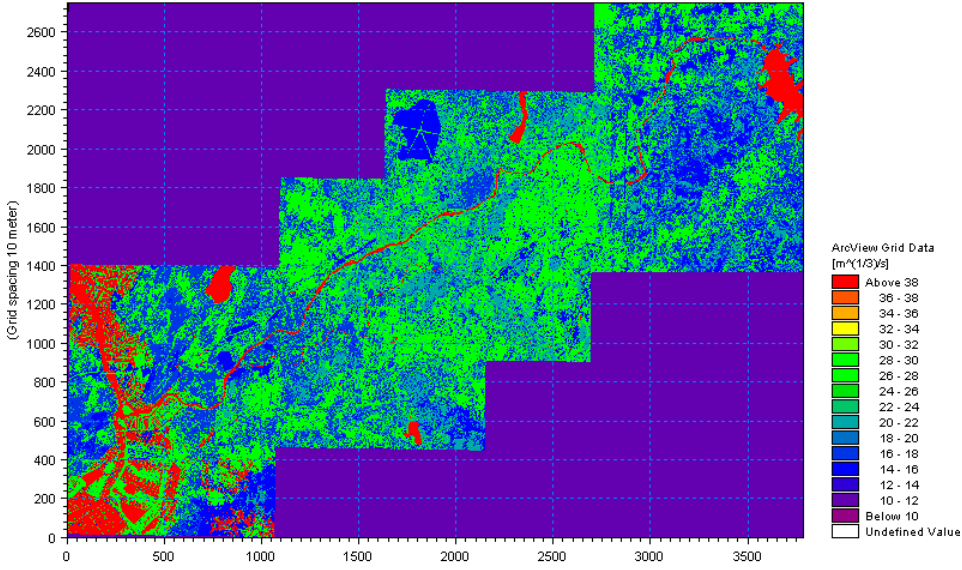
Figure 3. Manning map of the study area.